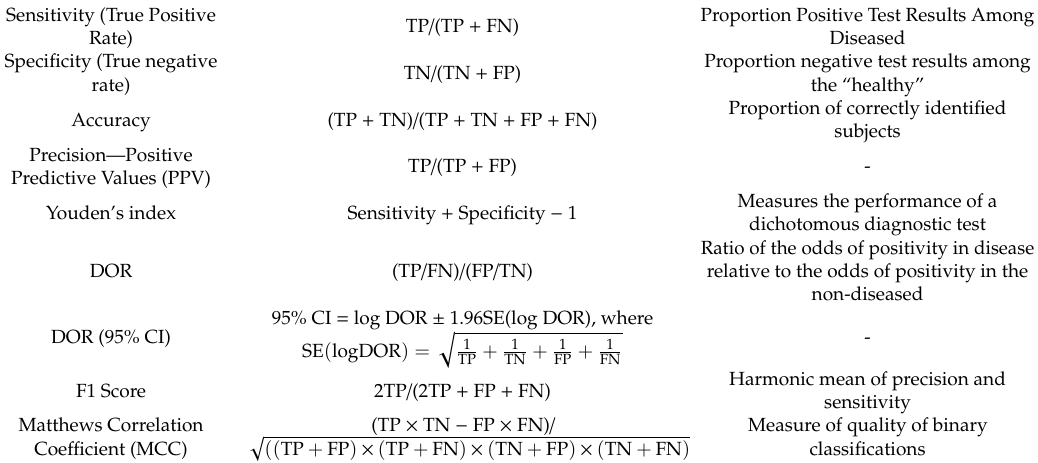
Table 1. Diagnostic performance indicators used in the comparative